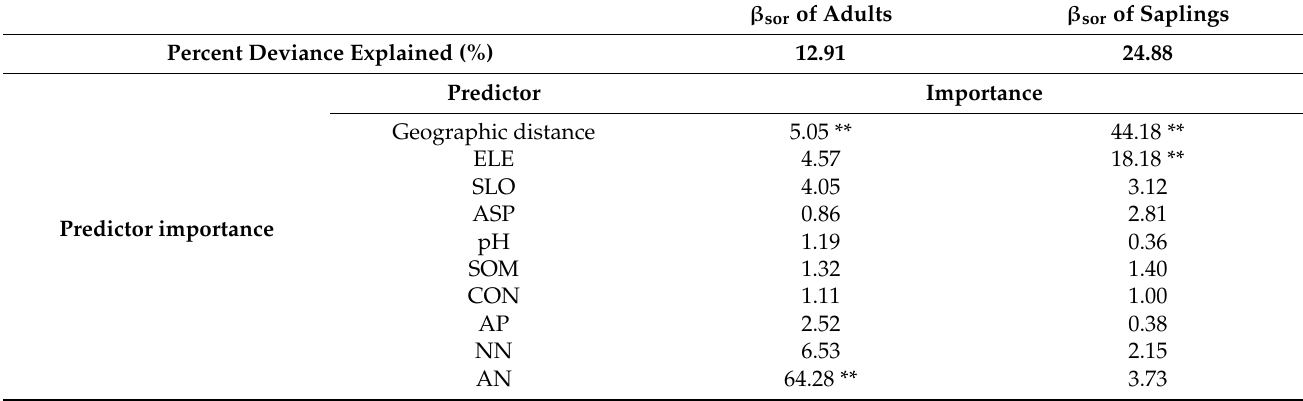
Table 3. Percent deviance in the strength of phylogenetic associations on geographic distance and environmental variables (ELE: elevation; SLO: slope; ASP: aspect; pH; SOM: soil organic mat- ter; CON: conductivity; AP: available phosphorus; NN: nitrate nitrogen; and AN: ammonium nitrogen) explained by generalized dissimilarity models (GDMs), and each predictor’s importance and significance. β sor of Adults β sor of Saplings Percent Deviance Explained (%) 12.91 24.88 Predictor Importance Geographic distance 5.05 ** Predictor importance